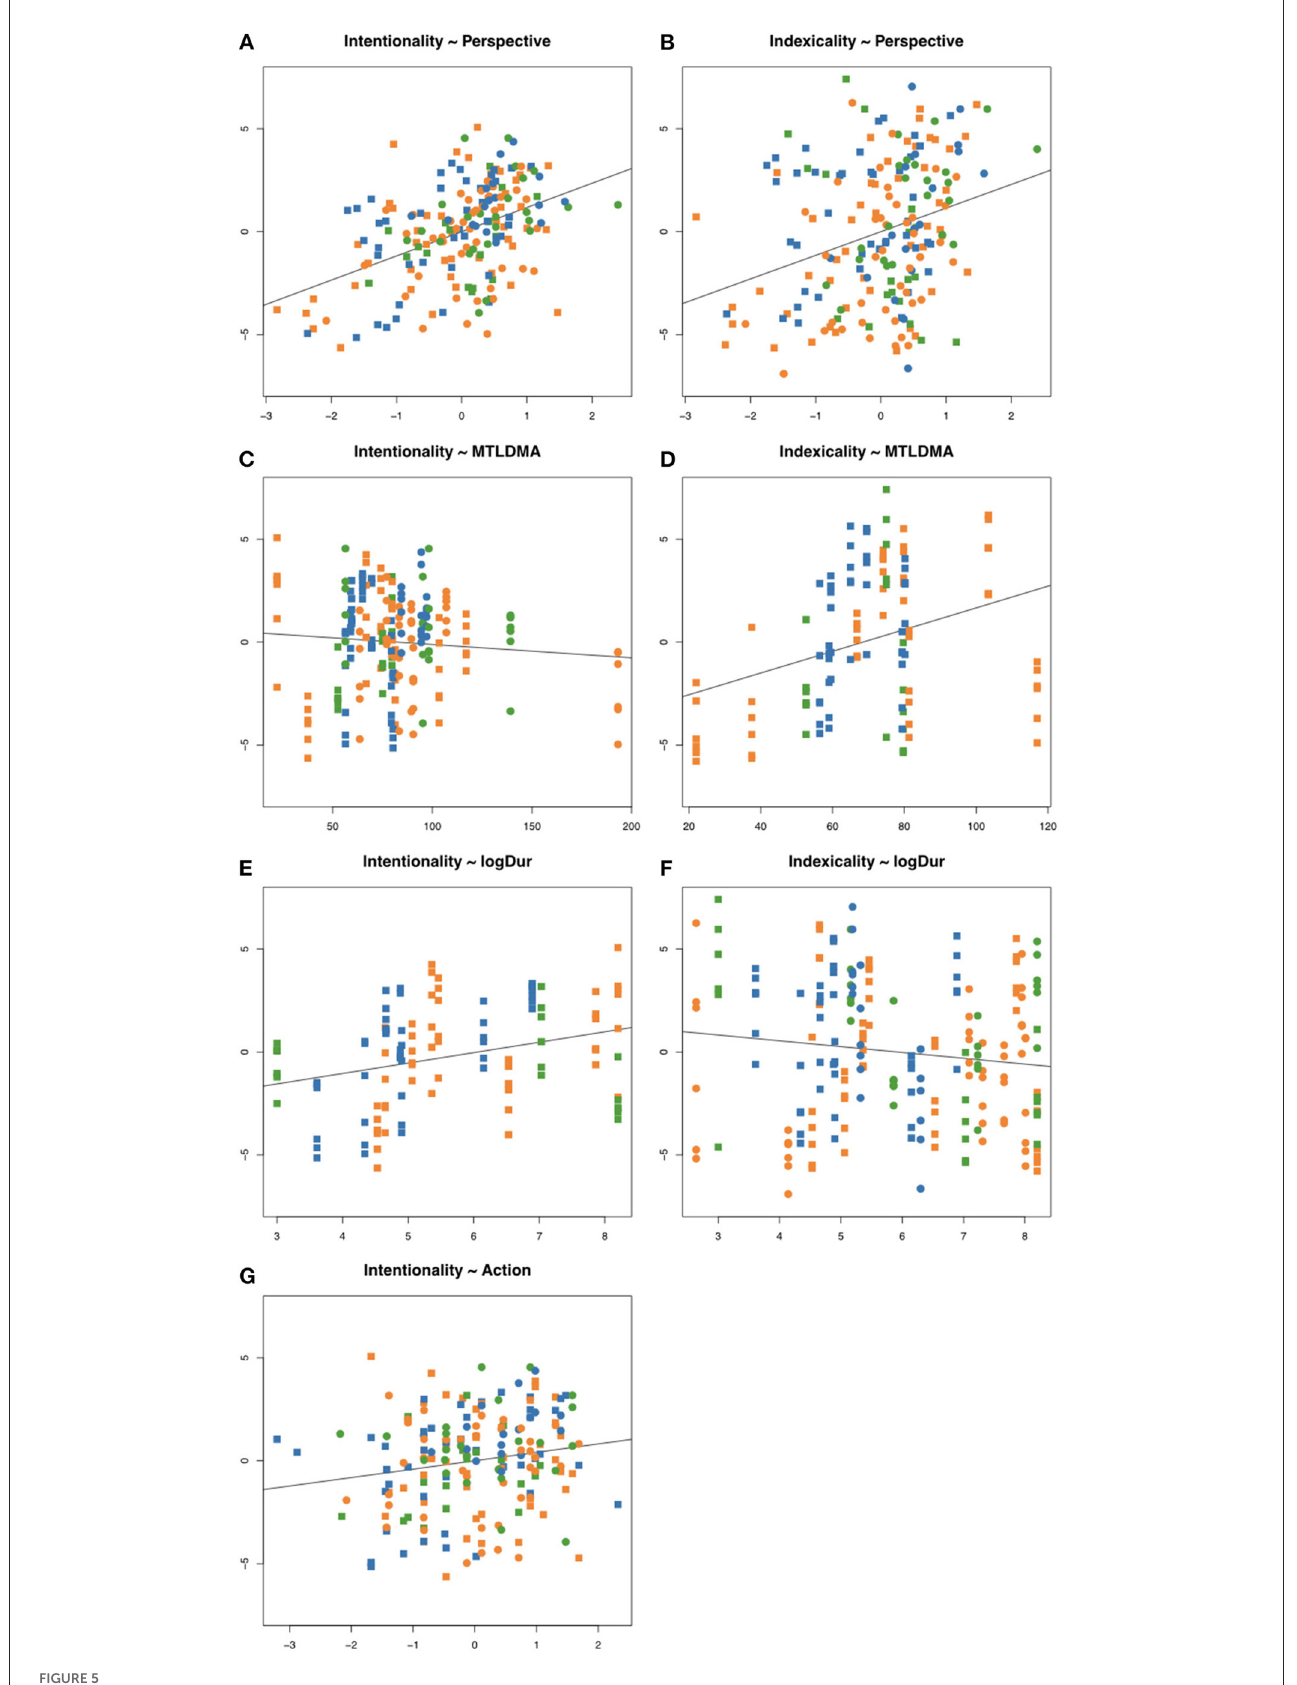
FIGURE5 Scatterplots of significant relationships in regression modeling. In all Panels, units for outcome variables (predictands) are the centered ratings of Intentionality (left column) and Indexicality (right column), derived from the eight scales spanning the Aesthetic Perspective Space. In each of Panels (A, B, G) , the predictors are the latent factors Perspective and Action, respectively, in the original units from ratings scales, and centered. In Panels (C, D) , the predictor is MTLDMA (lexical diversity), in original units (see section 2.1.2 for details). In Panels (E, F) , the predictor is duration (logarithmic; see section 2.1.1 for details). Shape and color of symbols are the same as in Figure